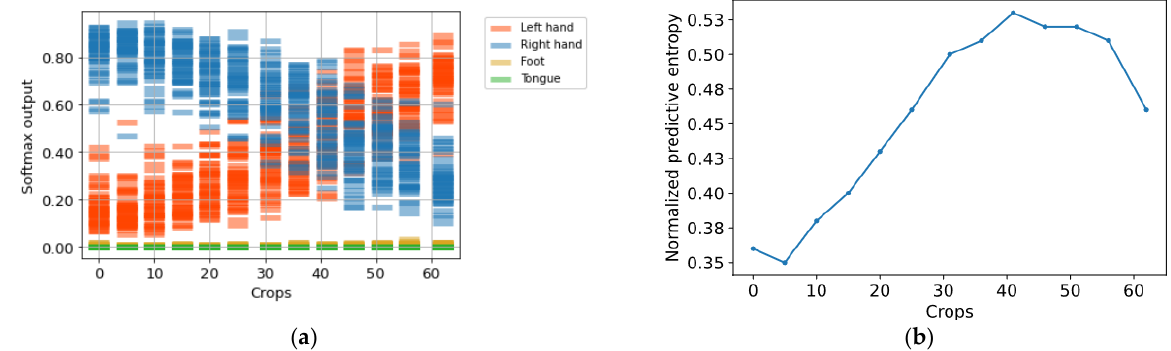
Figure 6. ( a ) Predictive distribution histograms of crops; ( b ) normalized predictive entropy of crops.